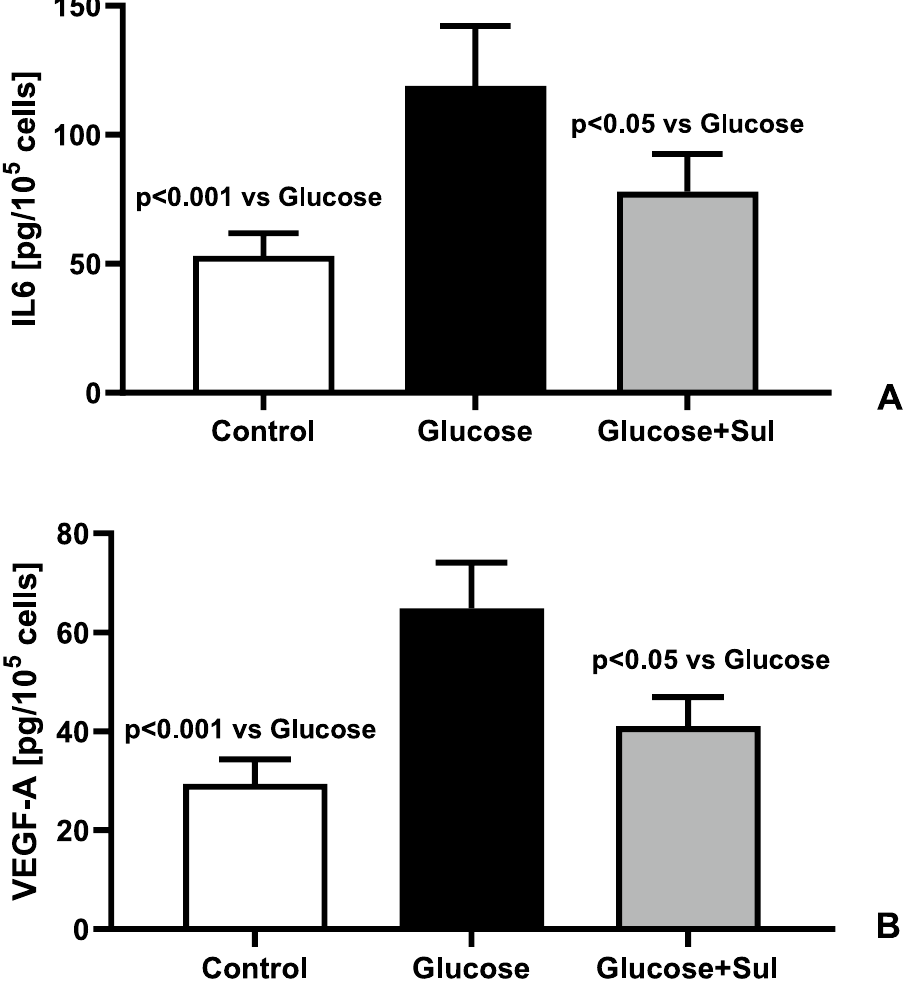
Figure 4. Secretion of IL6 ( A ) and VEGF-A ( B ) in HREC at the end of the replicative senescence in control medium (Control) medium supplemented with glucose 20 mmo/L (Glucose) and medium supplemented with glucose 20 mmol/L and Sulodexide 0.5 LRU/mL (Glucose + Sul) (n = 8) (ANOVA